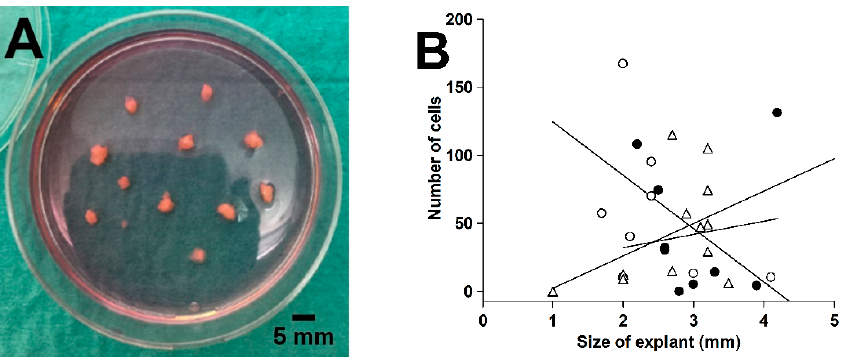
Figure 9. Explanted colorectal tissue for fibroblast expansion ( A ) and the effect of explant size on the cell outgrowth from 3 different tissue rings after 6 days in culture ( B ). Linear regression lines for the 3 tissues are shown in ( B ).